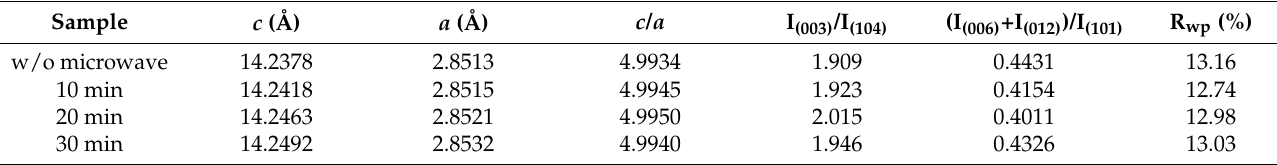
Figure 2. Rietveld refinement result of all LNCM samples prepared ( a ) without microwave irradiation (without microwave), and with ( b ) 10, ( c ) 20, and ( d ) 30 min of microwave irradiation. Table 1. The refined lattice parameter of the LNCM